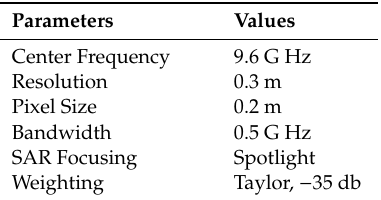
Table 2. Simulation